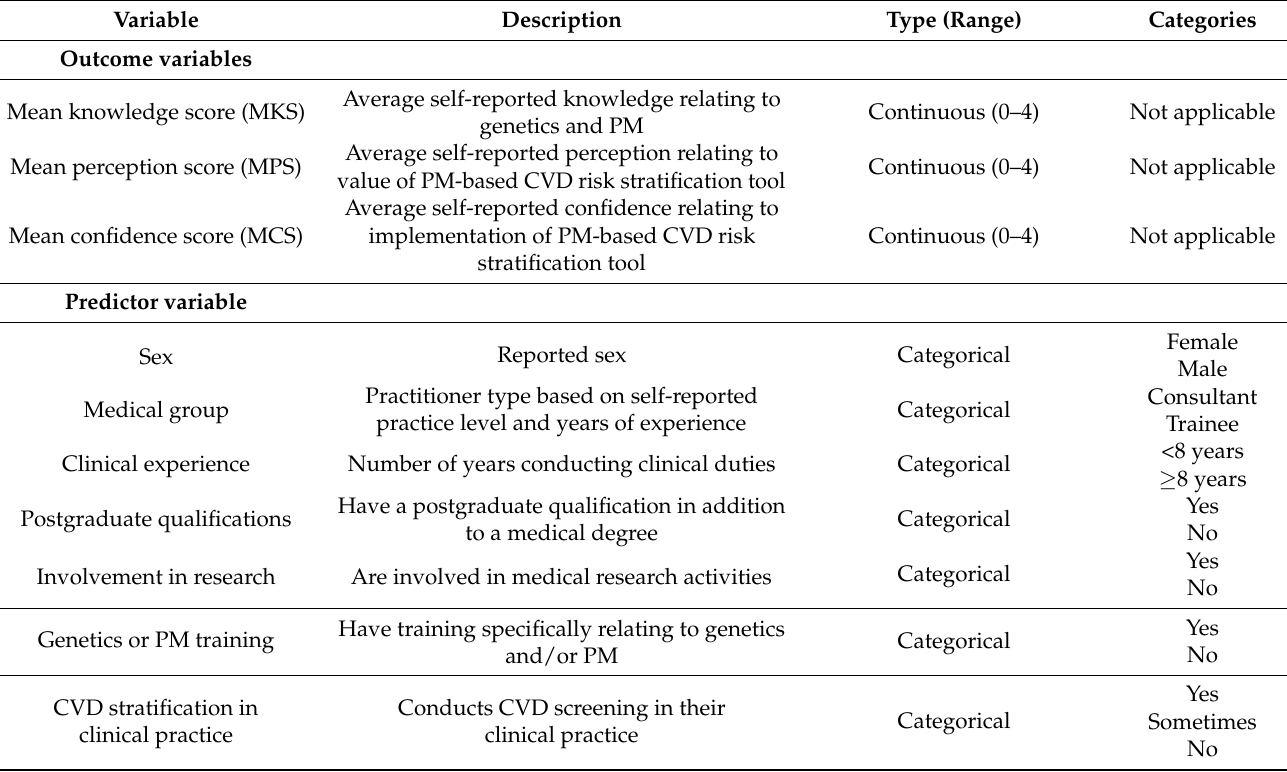
Table 2. Categorical and continuous predictor variables used for analysis in this